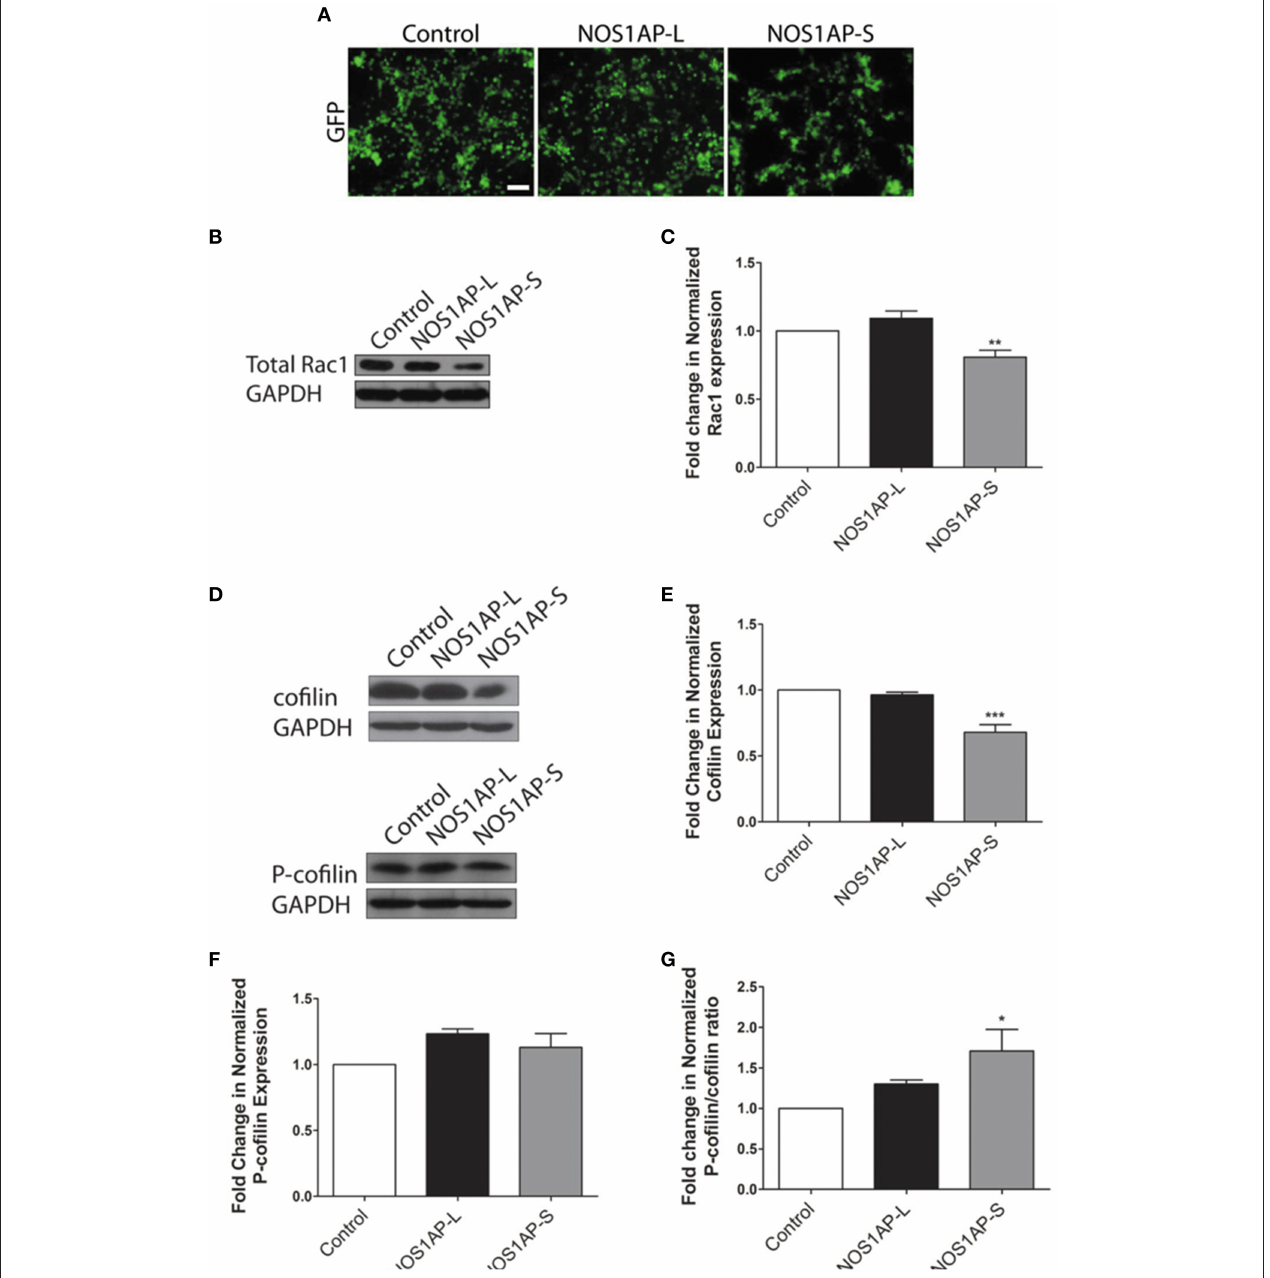
FIGURE 3 | NOS1AP-S decreases total Rac1 and cofilin protein expression in HEK293T cells. (A) Representative images of HEK293T cells expressing GFP (control), GFP-NOS1AP-L, or GFP-NOS1AP-S. Scale bar = 100 µ m. (B) Lysates from cultures of transfected HEK293T cells expressing GFP (control), NOS1AP-L, or NOS1AP-S were resolved by SDS-PAGE and analyzed by Western blotting using antibodies that recognize Rac1 and GAPDH to determine total Rac1 protein levels. Representative blot is shown. (C) Relative quantification of Rac1 normalized to control from multiple blots represented in (B) . Error bars indicate ± s.e.m. n = 9 for all conditions. (D) Lysates from cultures of transfected HEK293T cells (different than those in A) expressing GFP (control), NOS1AP-L, or NOS1AP-S were resolved by SDS-PAGE and analyzed by Western blotting using antibodies that recognize cofilin, phosphorylated cofilin (P-cofilin), and GAPDH. Representative blots are shown. (E) Relative quantification of total cofilin normalized to control from multiple blots represented in (D) . Error bars indicate ± s.e.m. n = 4 for all conditions. (F) Relative quantification of P-cofilin normalized to control from multiple blots represented in (D) . Error bars indicate ± s.e.m. n = 4 for all conditions. (G) Relative quantification of normalized P-cofilin/cofilin ratio from multiple blots represented in (D) . Error bars indicate ± s.e.m. n = 4 for all conditions. All analyses were performed by first normalizing to GAPDH as an internal loading control and then comparing experimental condition to GFP control condition. * p < 0.05, ** p < 0.01, and *** p < 0.001 vs. control. p -values were determined by one-way ANOVA followed by Dunnett’s Multiple Comparisons test.